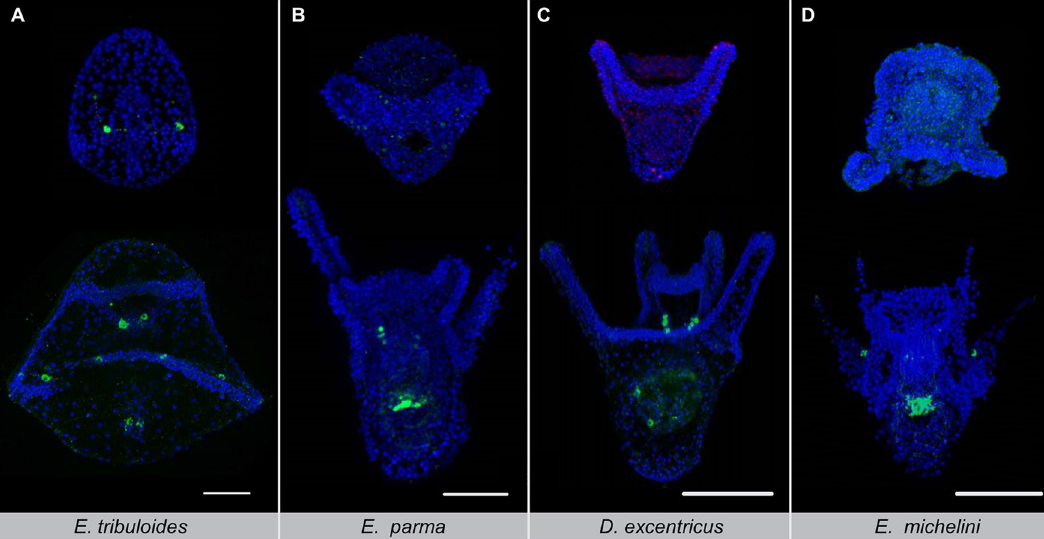
Figure 4. Dopaminergic development in the lateral ganglia was ancestrally present then lost. Immunodetection of the dopamine biosynthesis enzyme tyrosine hydroxylase (green) at prism or early pluteus stage (top row) and after feeding starts (bottom row) for the cidaroid, E. tribuloides ( A ), and irregular urchins, E. parma ( B ), D. excentricus ( C ), and E. michelini ( D ). DAPI counterstain, Blue. Scale bar, 100 µm for all